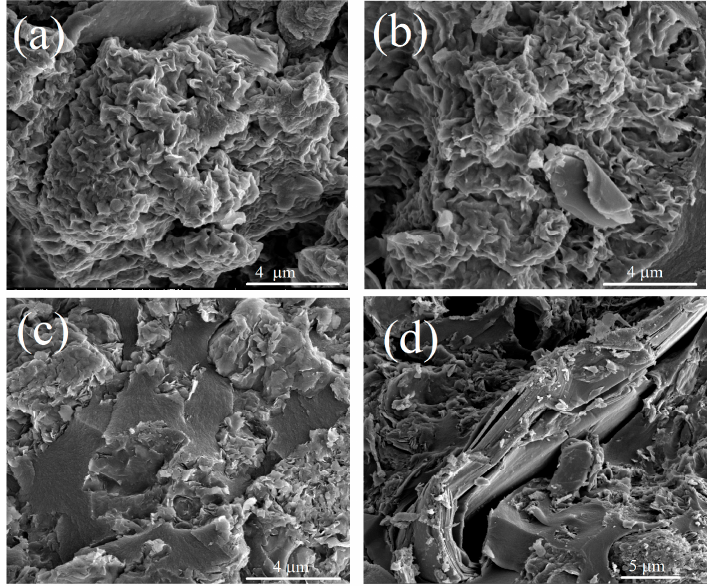
Figure 2. Sample morphology at microlevel (SEM) images of untreated nanocomposites RFR-76 ( a ), RFR-79 ( c ), and carbonized RFC-76 ( b ), RFC-79 ( d ) (scale bar 4–5 µ m).